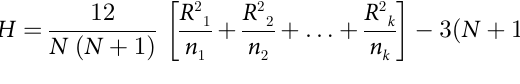
Hair et al. the cumulative value of the variance of more than 60 percent can be accepted. There-